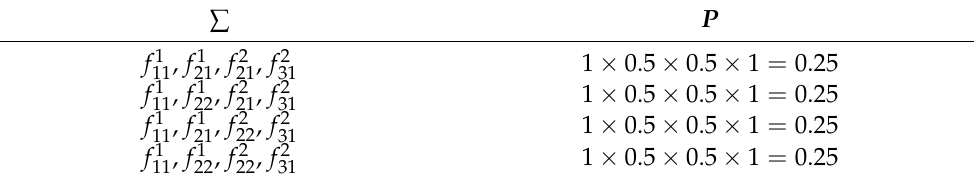
Table 1. Sub-Model of